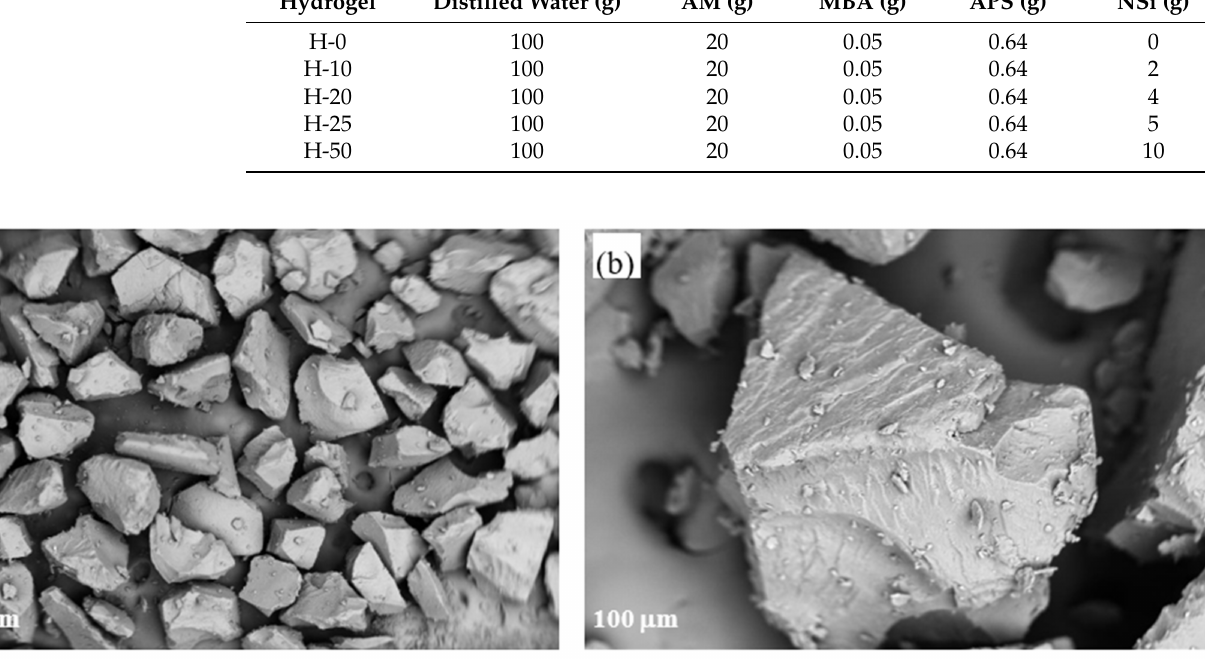
Figure 1. ( a ) and ( b ) Scanning electron images at different magnifications of the hydrogel with NSi